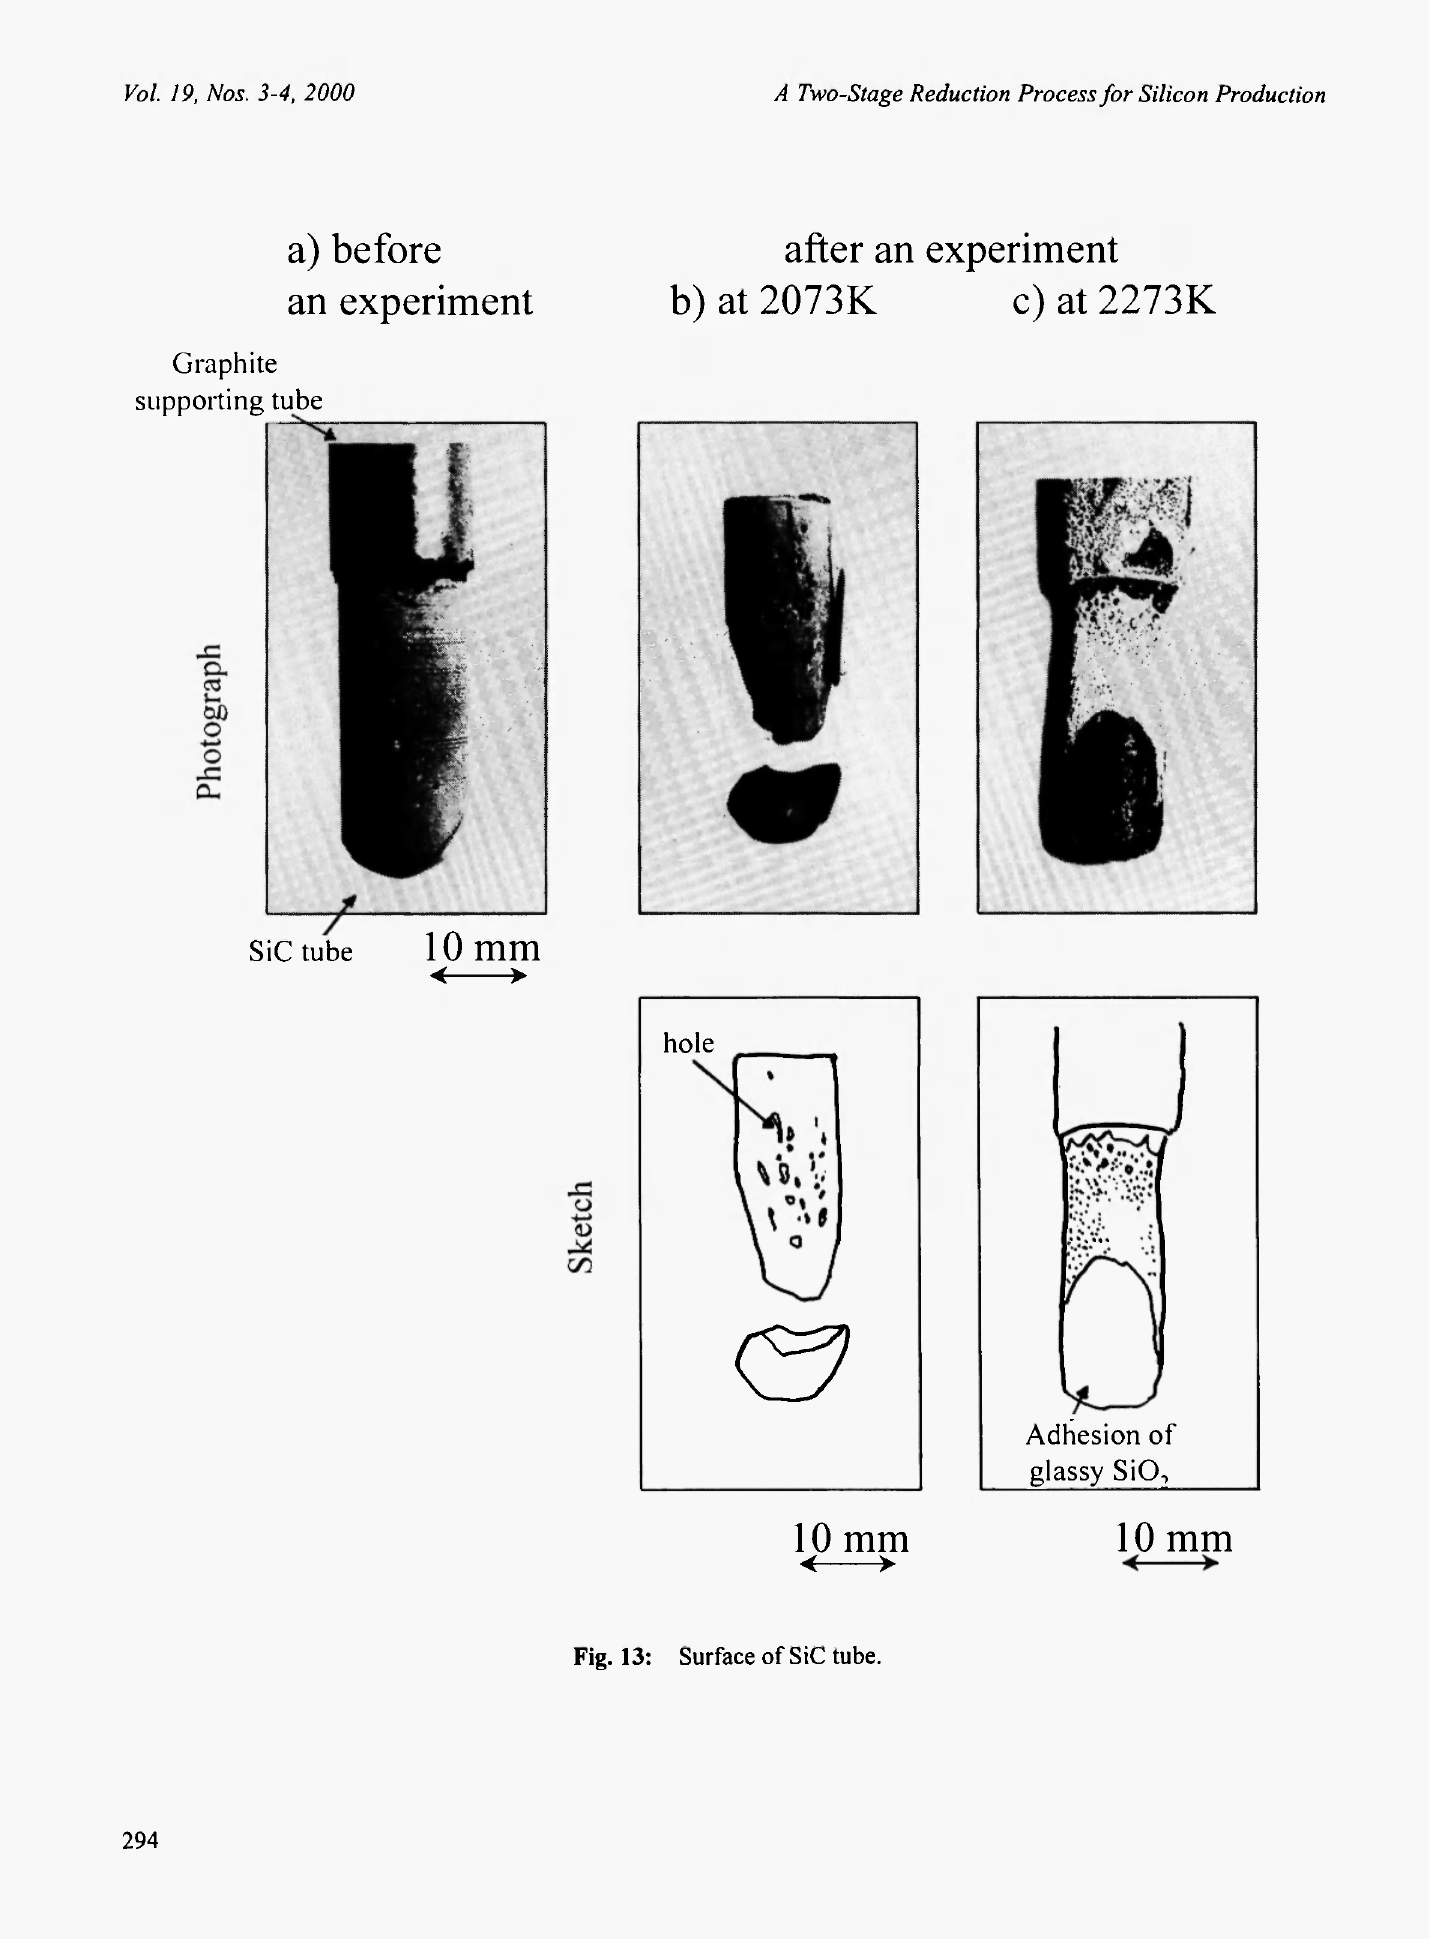
Fig. 13: Surface of SiC